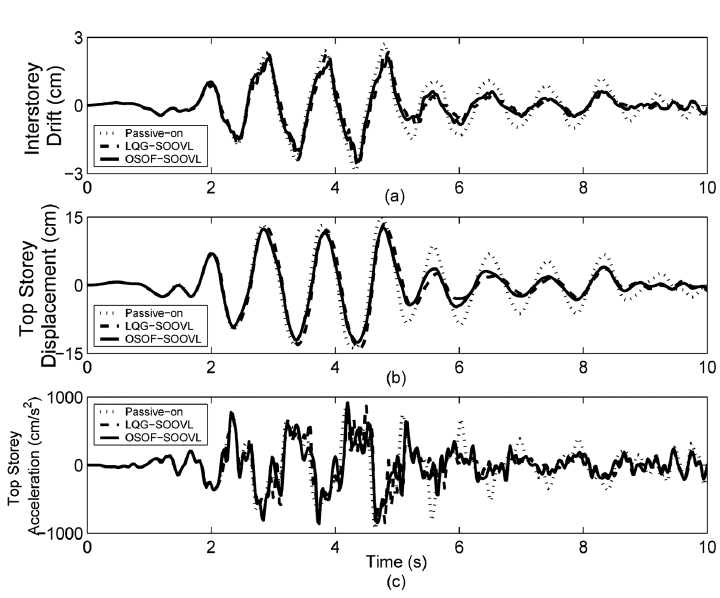
Fig. 7. Time histories (a) Second storey interstorey drift; Top storey (b) displacement, (c)